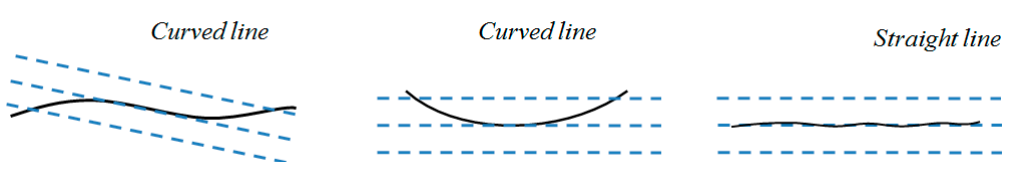
Figure 6. Examples of straight line test